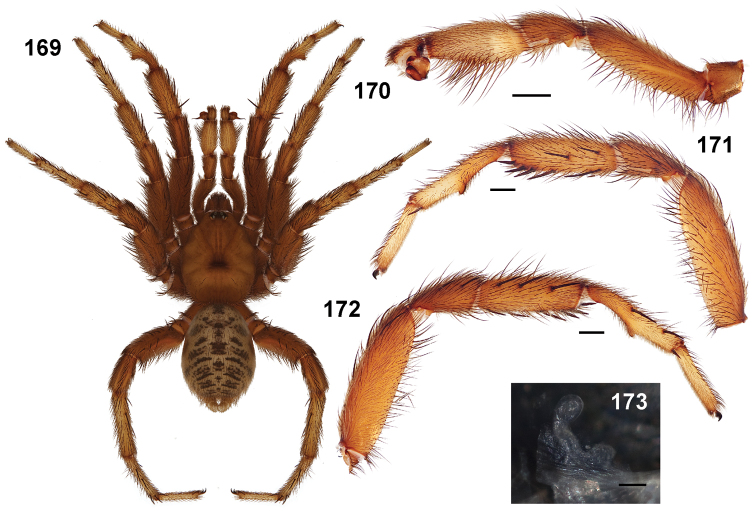
Aptostichus muiri sp. n. from Mariposa Co. 169–172 male holotype (AP409); scale bars = 1.0mm 169 habitus [805918] 170 retrolateral aspect, pedipalp [805916] 171 retrolateral aspect, leg I [805910] 172 prolateral aspect, leg I [805914] 173 female paratype (AP1263), cleared spermathecae [805906]; scale bar = 0.1mm.